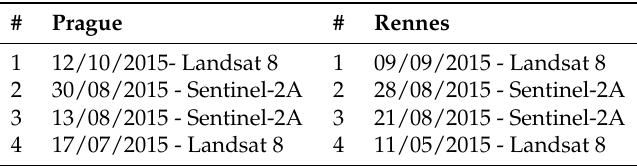
Table 1. List of input